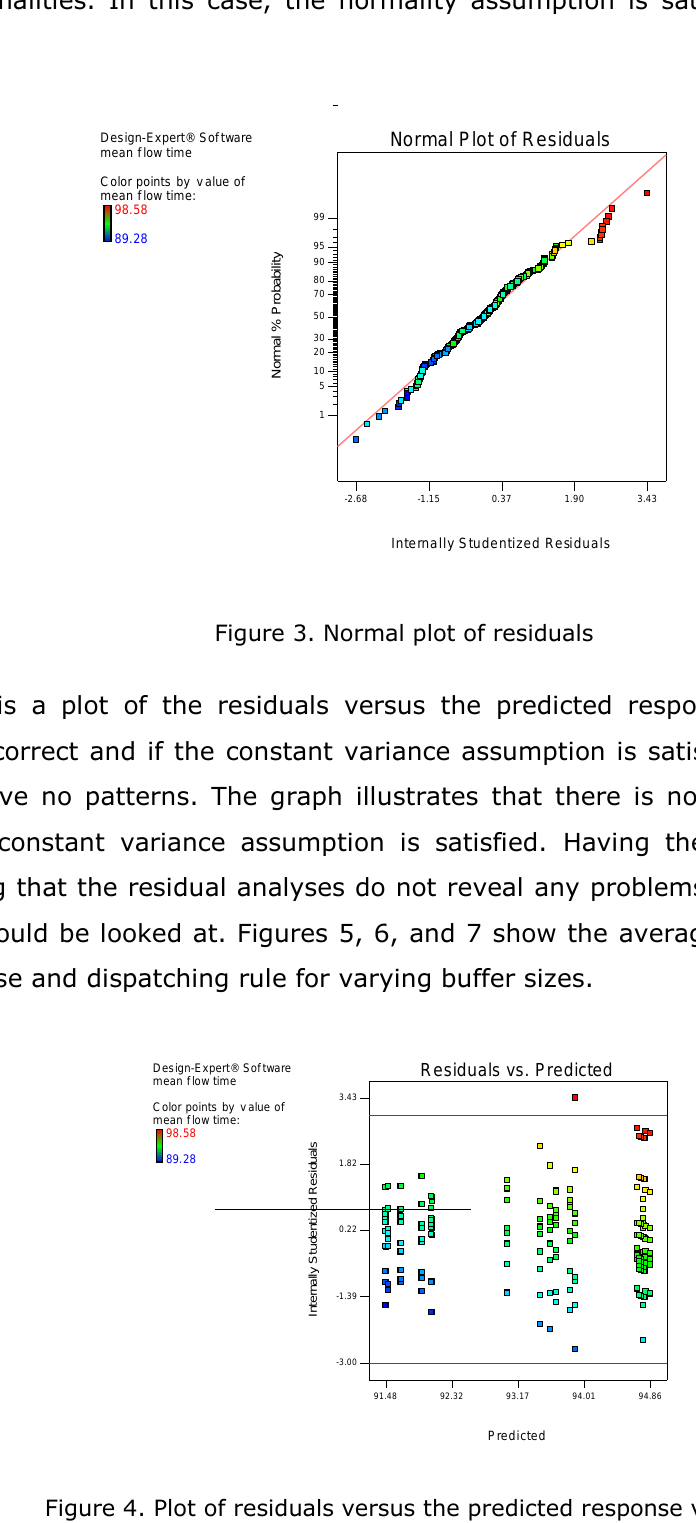
Figure 4. Plot of residuals versus the predicted response